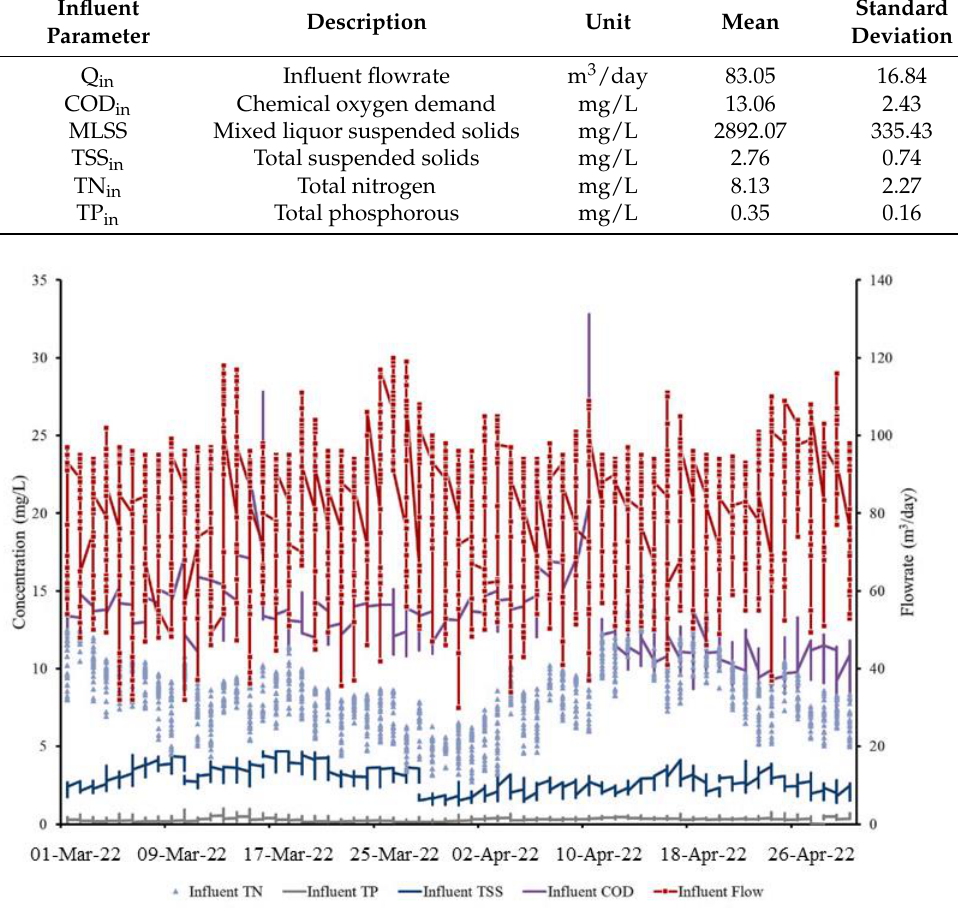
Figure 2. Influent conditions from the full-scale WWTP